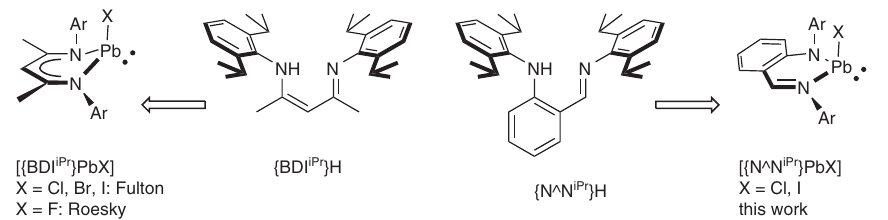
Figure 1: Three-coordinate mononuclear lead(II) halides and their